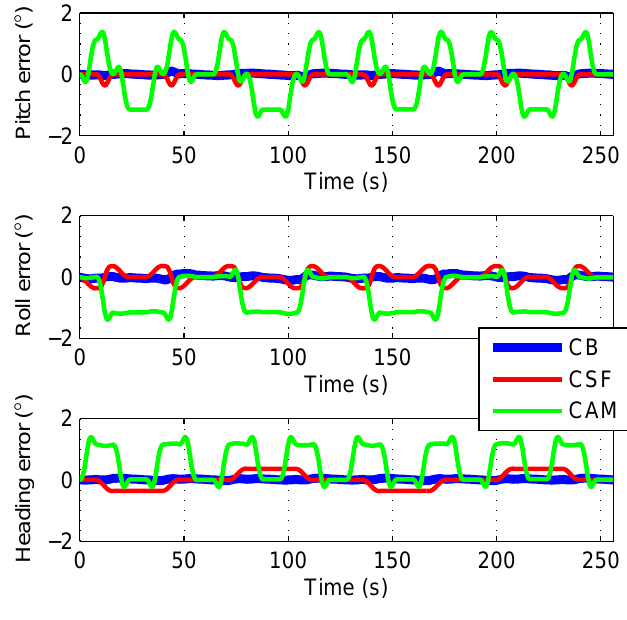
Figure 6. Attitude and heading errors caused by different error